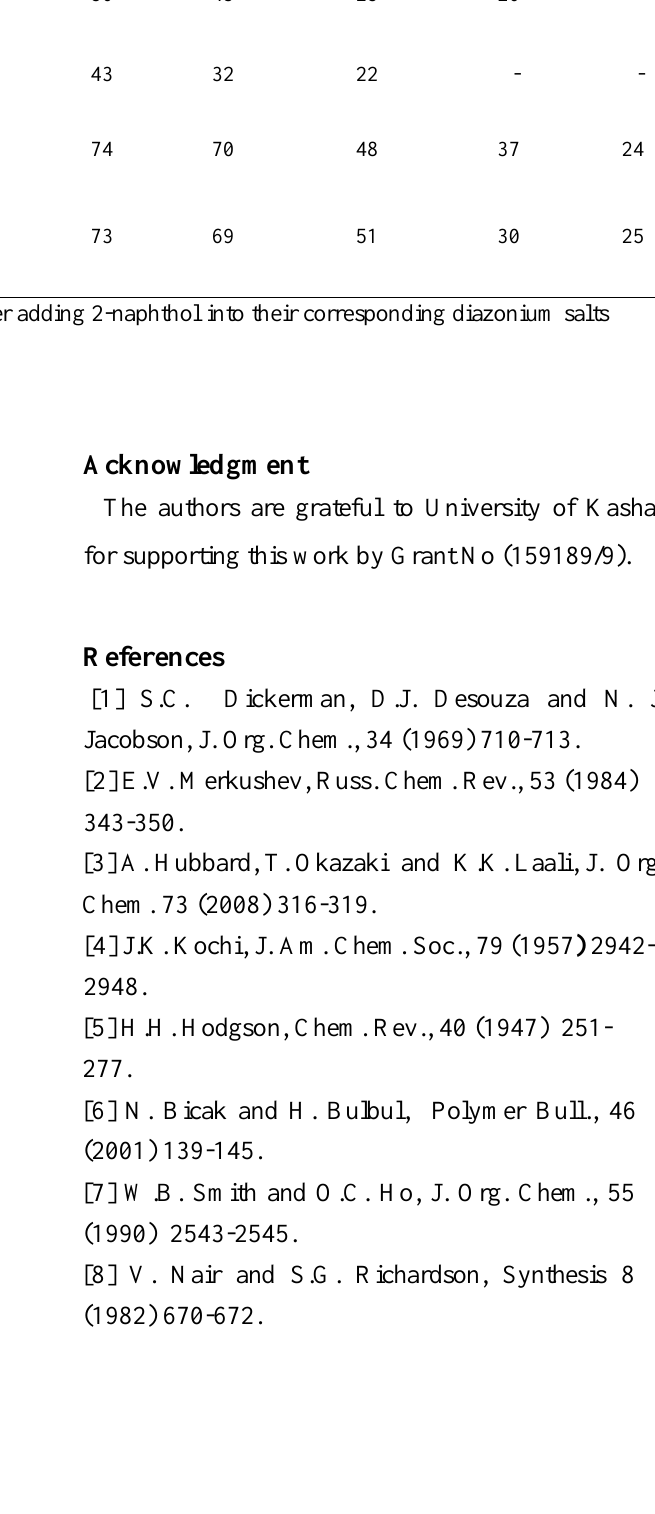
Table 4. The stability study of some aryl diazonium silica periodate at room temperature Diazonium salt Prduct 30 min 1 day 2 days 3 days N 2+ IO 4